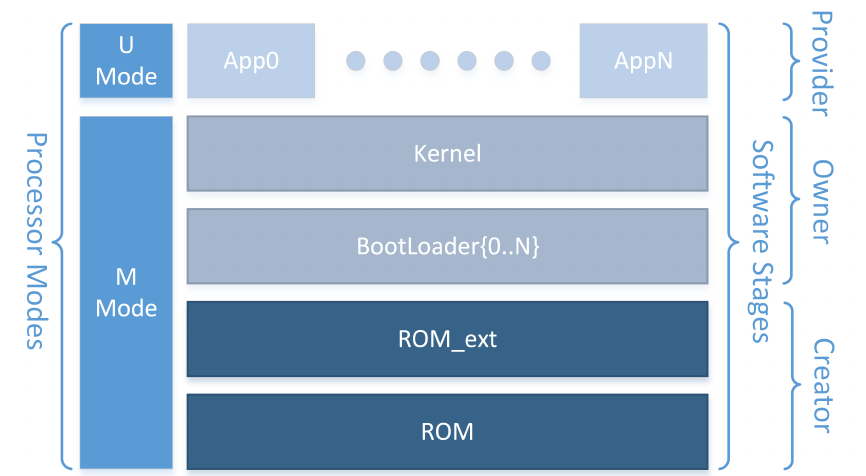
Figure 4. Software stages of the OpenTitan secure boot procedure with respect to particular levels owners, based on [62]. Only low level software layers (ROM, ROM_ext) are provided with the solution (Silicon Creator level), while the end user (Silicon Owner) is responsible for all higher phases of secure boot as well as the isolation of executed applications when the system is already